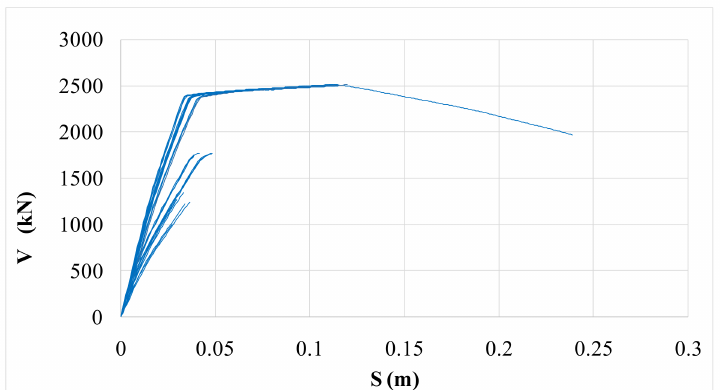
Figure 6. Capacity curves (Base shear V—Roof displacement S) of the building under study (current state, longitudinal and transversal